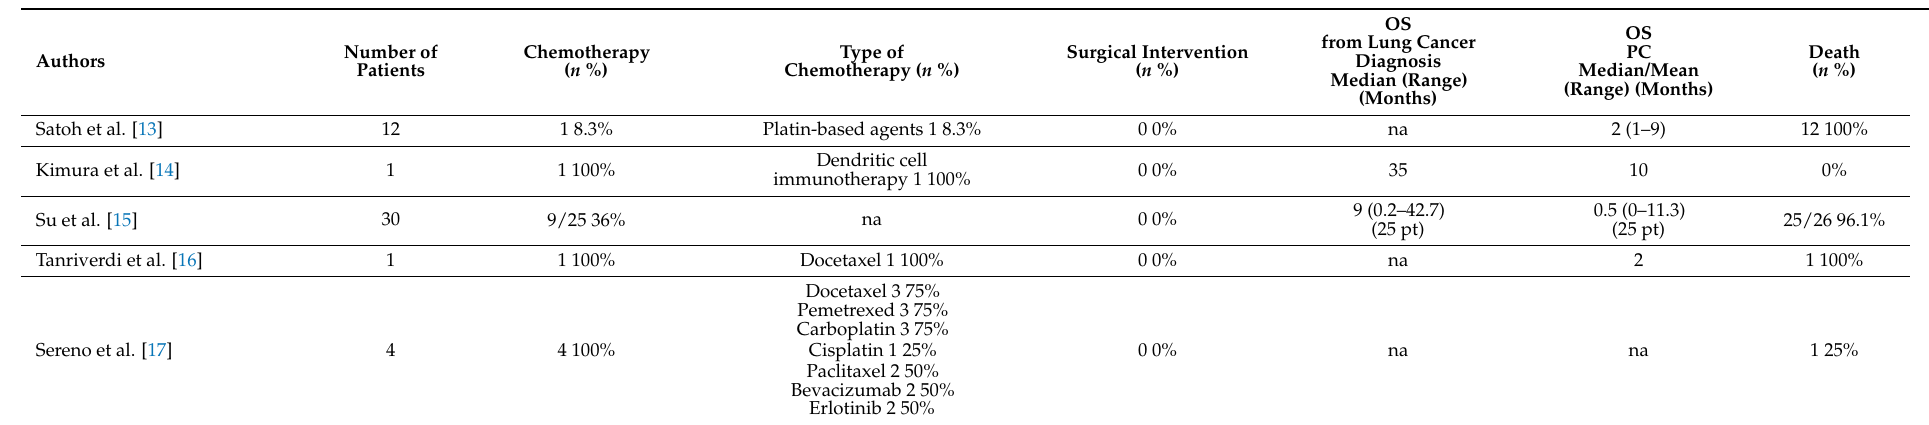
Table 3. Management and outcomes of peritoneal carcinosis from lung